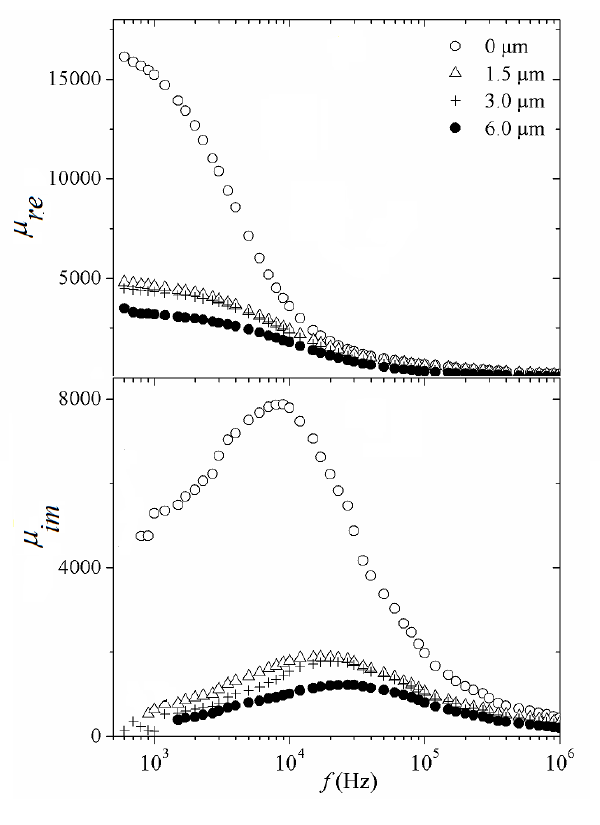
Figure 14. Real and imaginary permeability spectra for biphase wires with hard layer thickness t (microns) as a